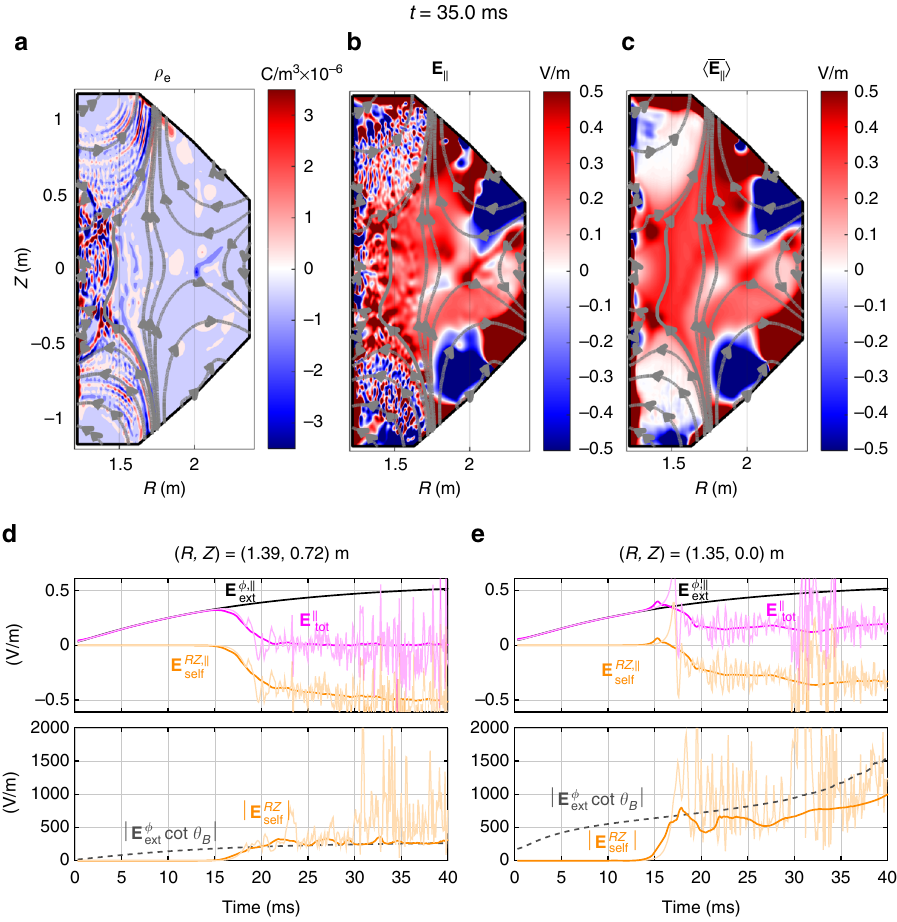
Fig. 4 Fluctuating electric fi eld and its temporal average. a , b show snapshots at t = 35 ms for fl uctuating charge densities and parallel component of the total electric fi elds, respectively. c is a snapshot of the temporal average of the fl uctuating total electric fi elds. d , e show temporal evolutions of the electric fi elds at two different points, respectively. Upper panels show the parallel components of external (black), self (orange), and total (magenta) electric fi eld, and lower panels show the magnitudes of the self-electric fi elds in the RZ plane (orange) and their theoretical predictions in the ideal condition (Eq. (2), dashed gray). Thin and transparent sold lines are fl uctuating electric fi elds measured in every 100 μ s, and thick and opaque lines are the mean electric fi elds averaged over 3